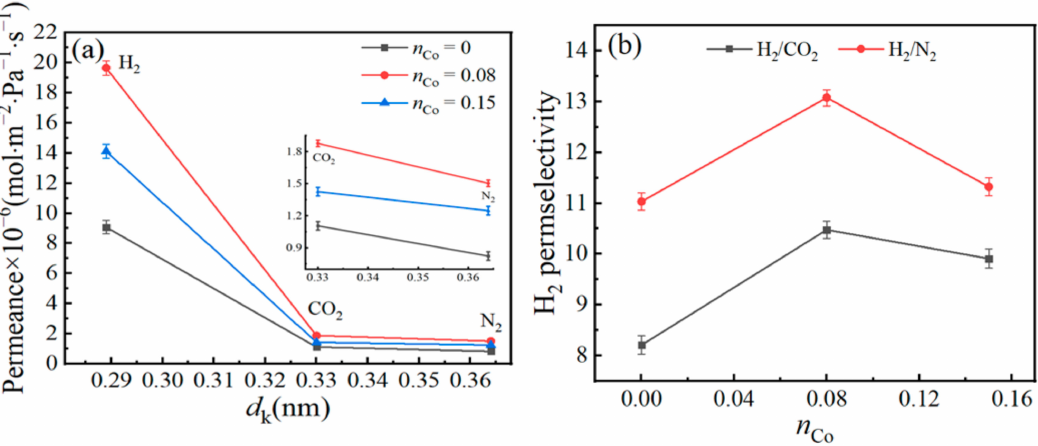
Figure 7. ( a ) Gases’ (H 2 , CO 2 , and N 2 ) permeances versus gas molecules’ kinetic diameters ( d k ) and ( b ) H 2 perm-selectivities of supported Co/MSiO 2 membranes with various n Co at a pressure difference of 0.2 MPa and 200 ◦ C.